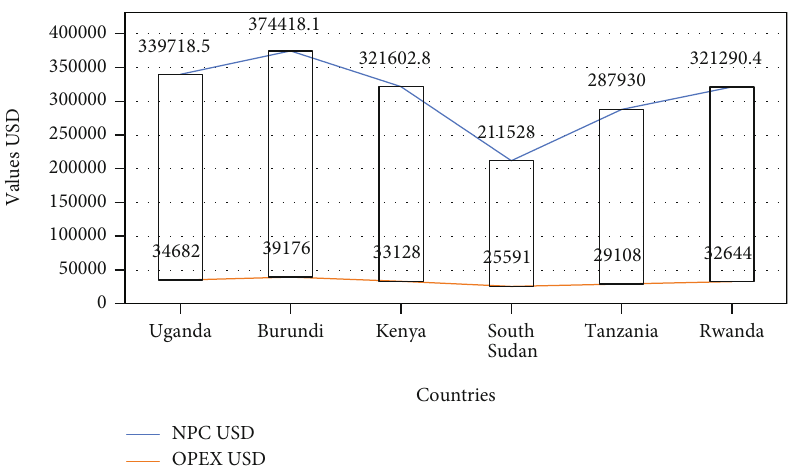
Figure 9: NPC and OPEX with the diesel + PV